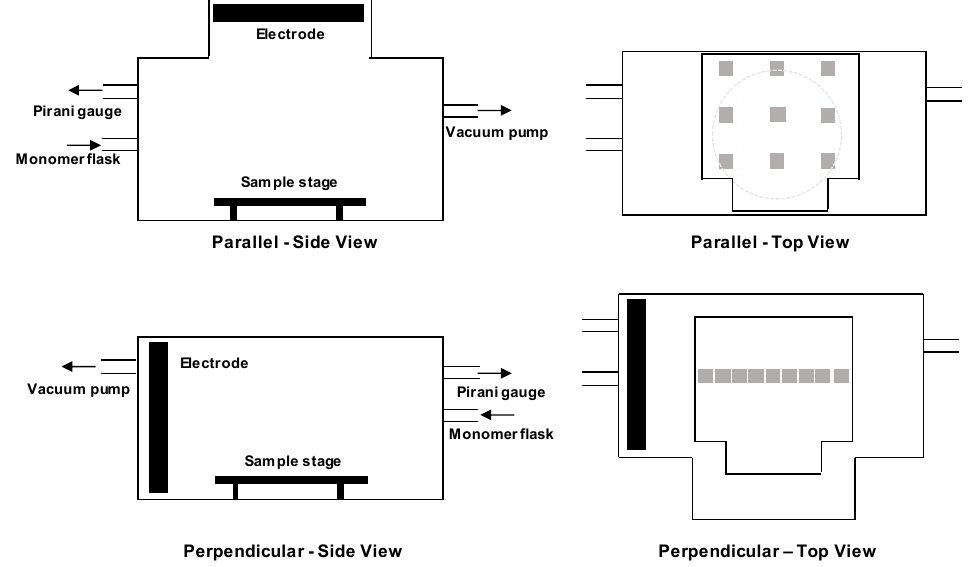
Figure 1. Schematic diagram of side and top views for parallel and perpendicular plasma reactor configurations.